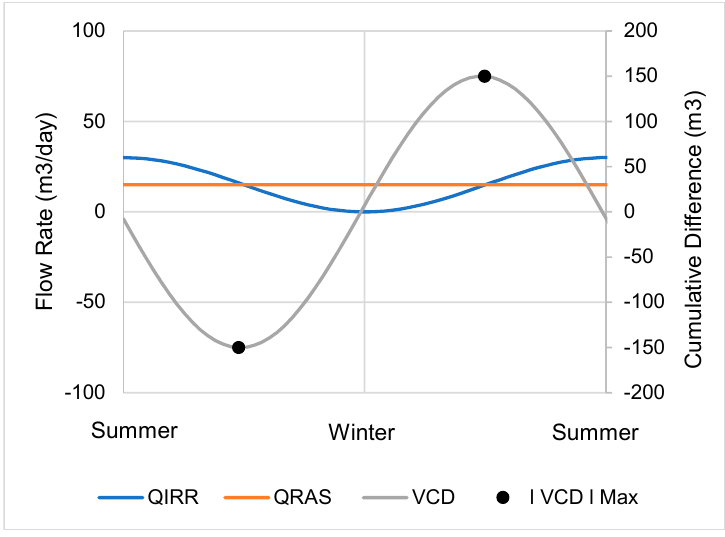
Figure 2. Conceptual seasonal variation in water supply, demand and cumulative difference, for a recirculating aquaculture system discharging 15 m 3 day − 1 .